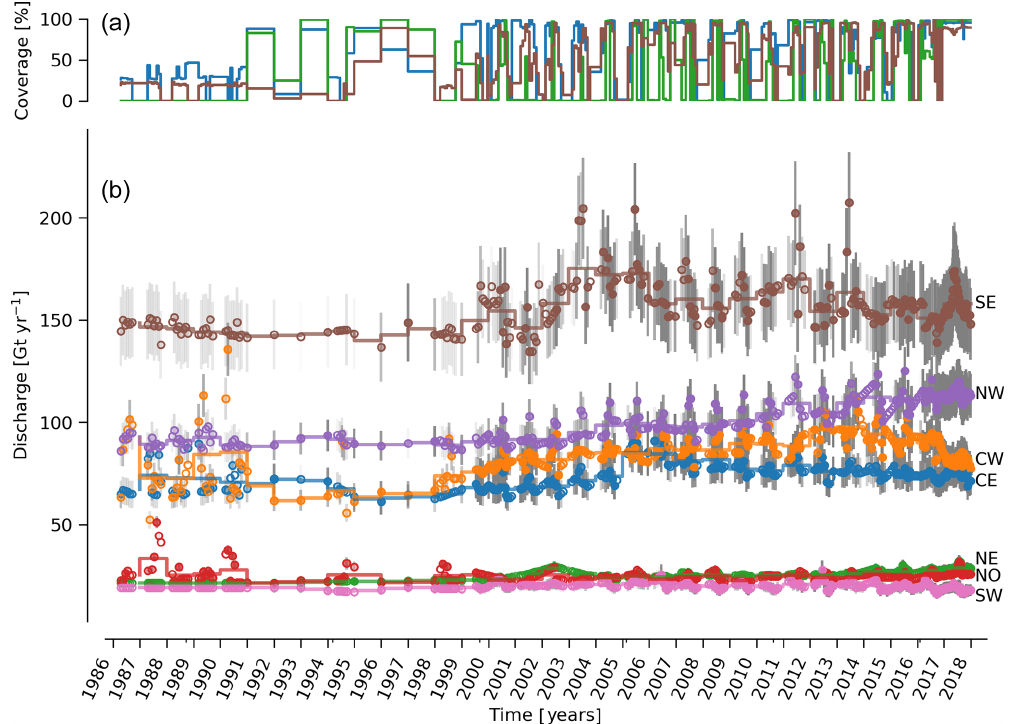
Figure A4. Same as Fig. 5 but without the velocity filter. Note the different y axis.